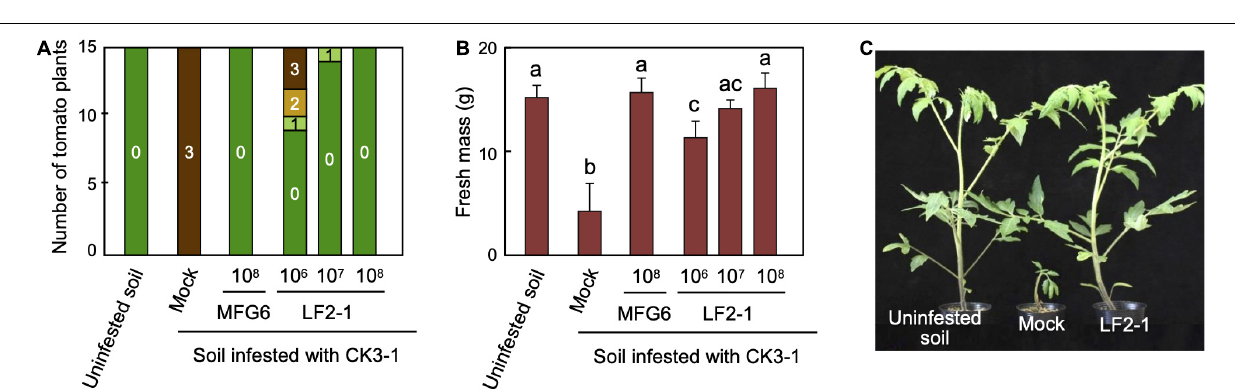
FIGURE 1 | Biocontrol activity of pathogenicity gene mutants of Fusarium oxysporum f. sp. melonis against the parental strain. Roots of melon seedlings were dipped in a conidial suspension (1 × 10 6 , 10 7 or 10 8 conidia/mL) of (cid:49) FOW2 (MF2-1), (cid:49) FMK1 (MK1), and (cid:49) FRP1 (RP1) strains of F. oxysporum f. sp. melonis or nonpathogenic strain MFG6. The seedlings were planted in soil infested with the parental wild-type strain Mel02010 (1 × 10 5 conidia/g soil). Control seedlings were immersed in water and planted in uninfested or infested soil (Mock). (A) Symptoms were scored at 21 dpi as 0, no symptoms; 1, yellowing; 2, wilted; 3, dead. (B) Plants at 21 dpi.